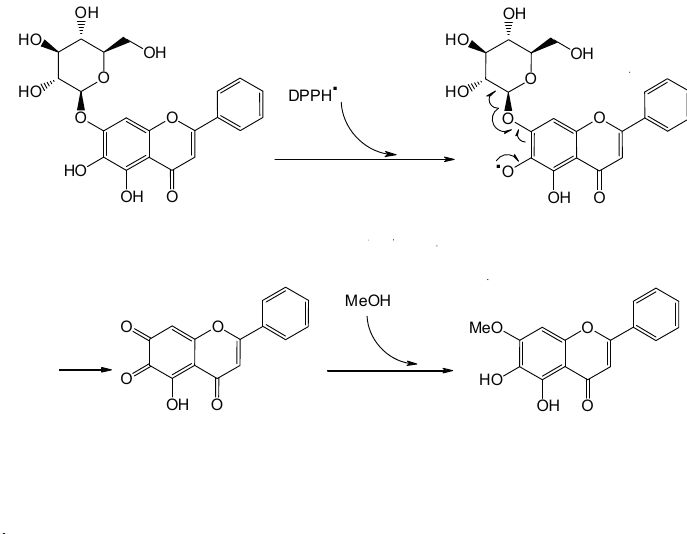
Figure 4 . Plausible reaction route of flavonoid glycosides with DPPH, using baicalein-7- O -glucoside as an